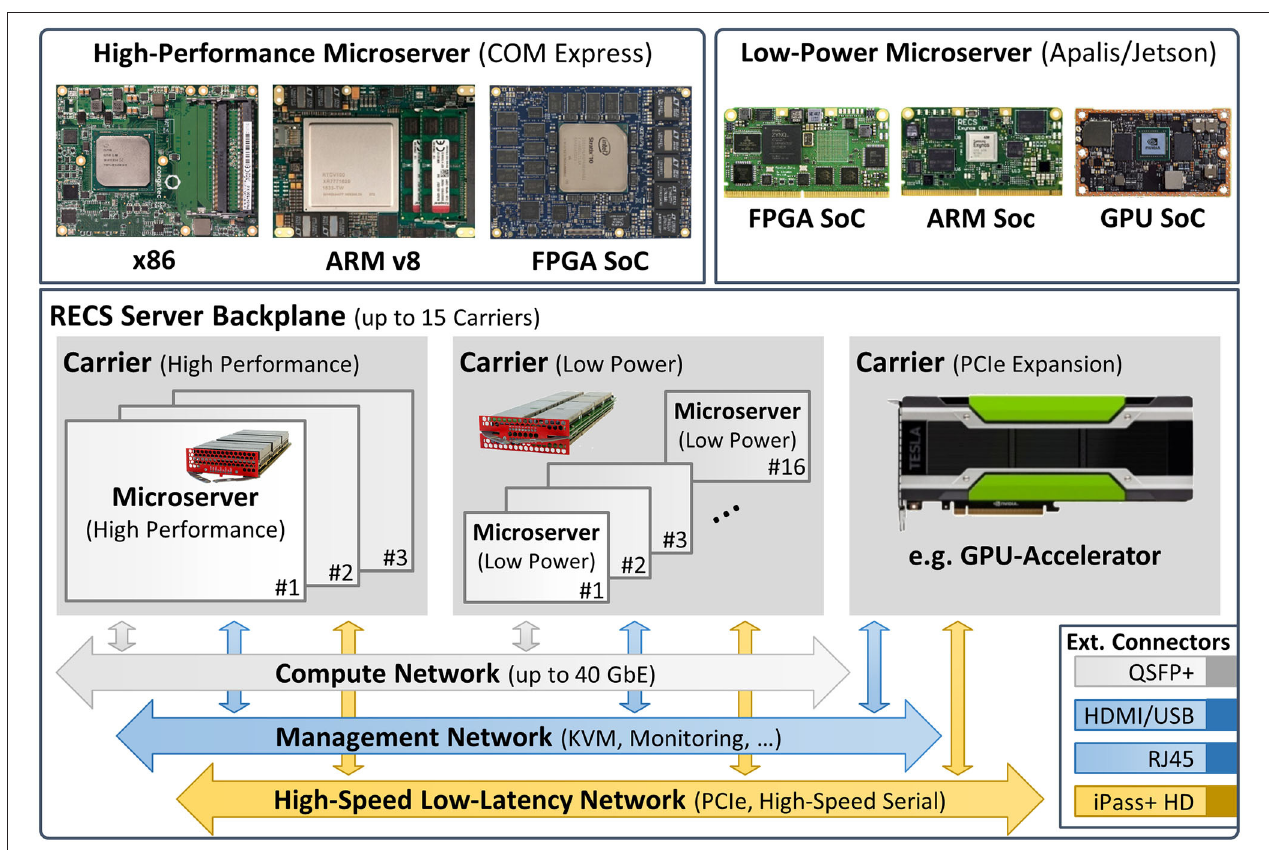
FIGURE 5 | Overview of the RECS|Box hardware